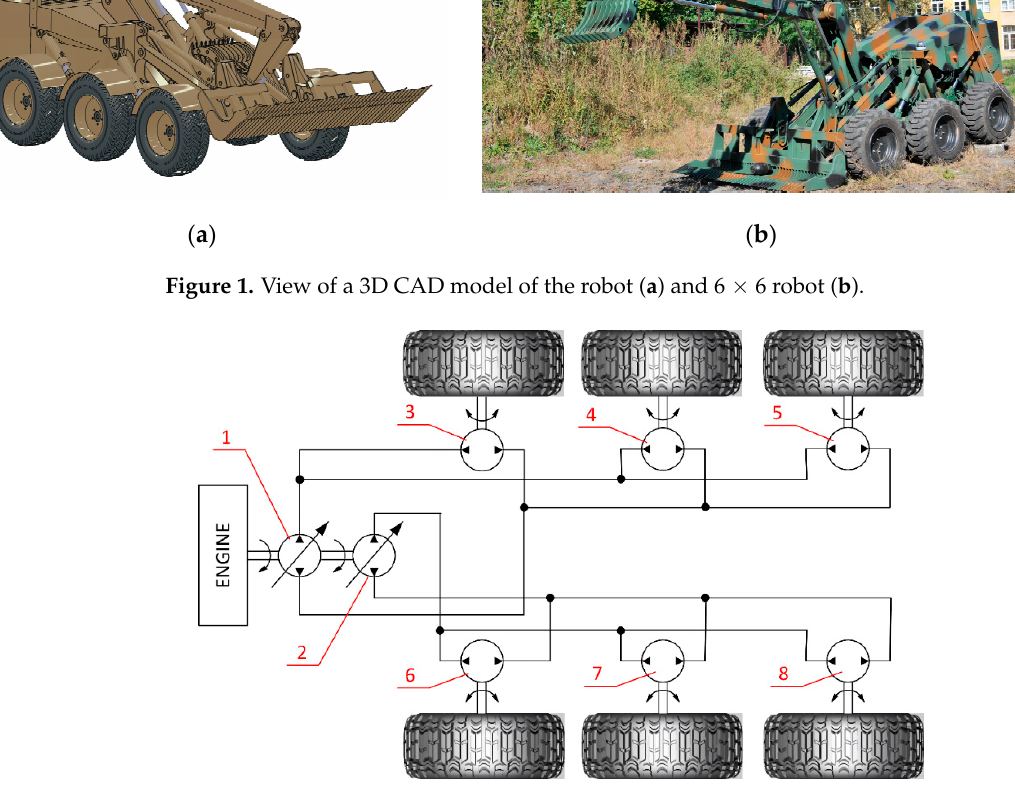
Figure 1. View of a 3D CAD model of the robot ( a ) and 6 × 6 robot ( b ).